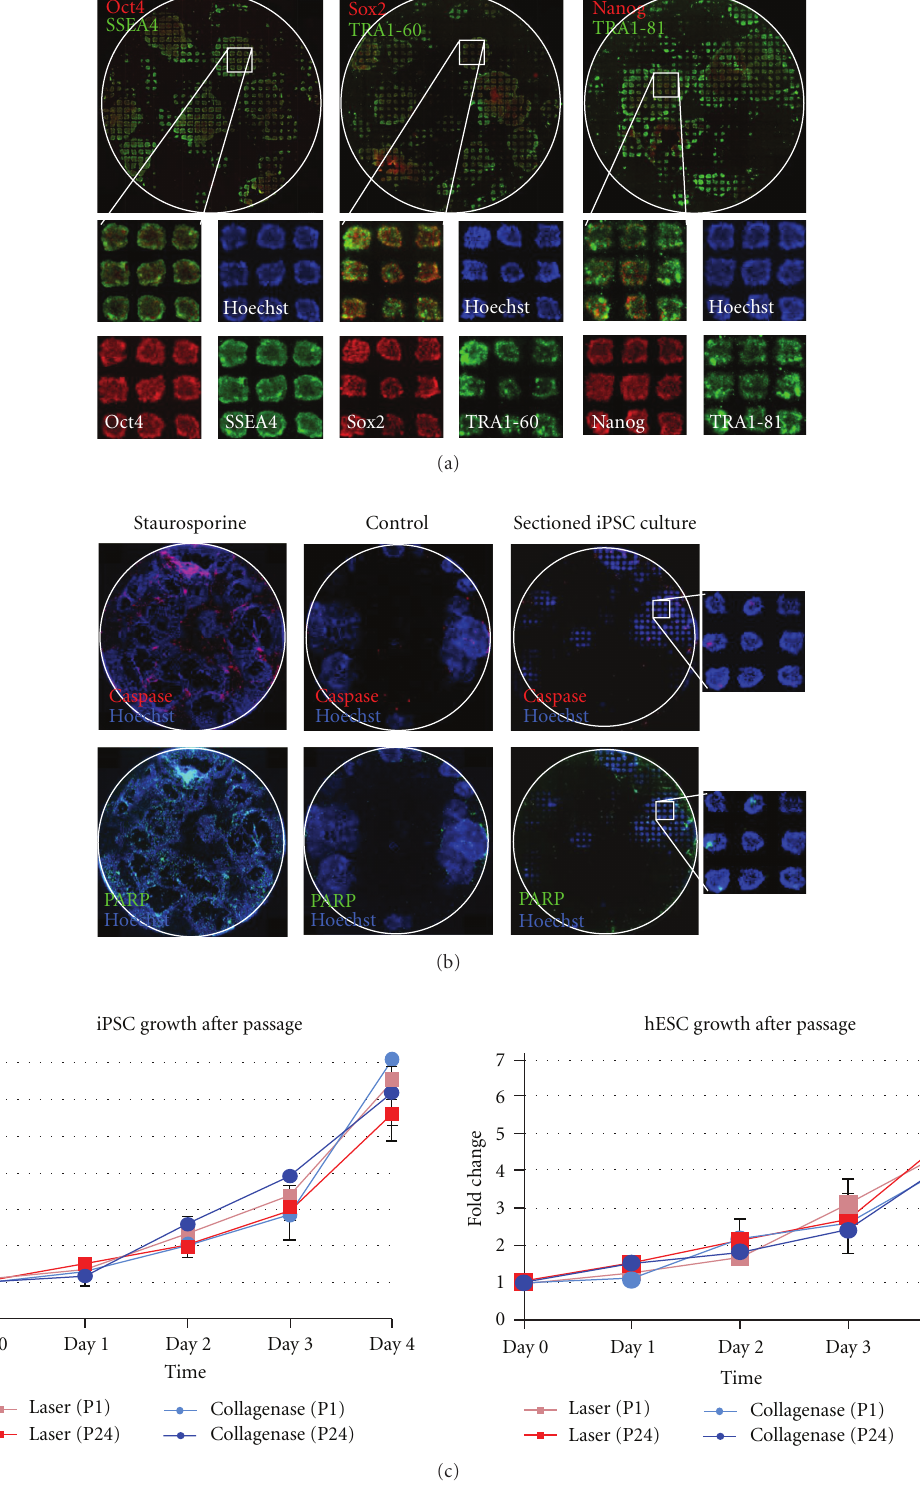
Figure 3: Quality of iPSC cultures after laser-mediated passage. (a) Immunocytochemical analysis of Oct4, Sox2, Nanog, SSEA4, TRA1-60, and TRA1-81 expression immediately following laser-mediated sectioning of iPSC cultures (BIMR L) into 200 μ m sections. Hoechst was used as a nuclear counterstain. Note that all markers are expressed homogeneously across iPSC clumps. Scale bar, 1mm. (b) Immunocytochemical analysis of apoptosis markers, caspase-3, and cleaved PARP, following laser-mediated sectioning of iPSC cultures. Hoechst was used as a nuclear counterstain. Scale bar, 1 mm. (c) Analysis of iPSC (BIMR 6, left) and ESC (H9, right) growth following propagation using laser- mediated passage or collagenase passage. P indicates passage number. Data are shown as mean + s.d. ( n =